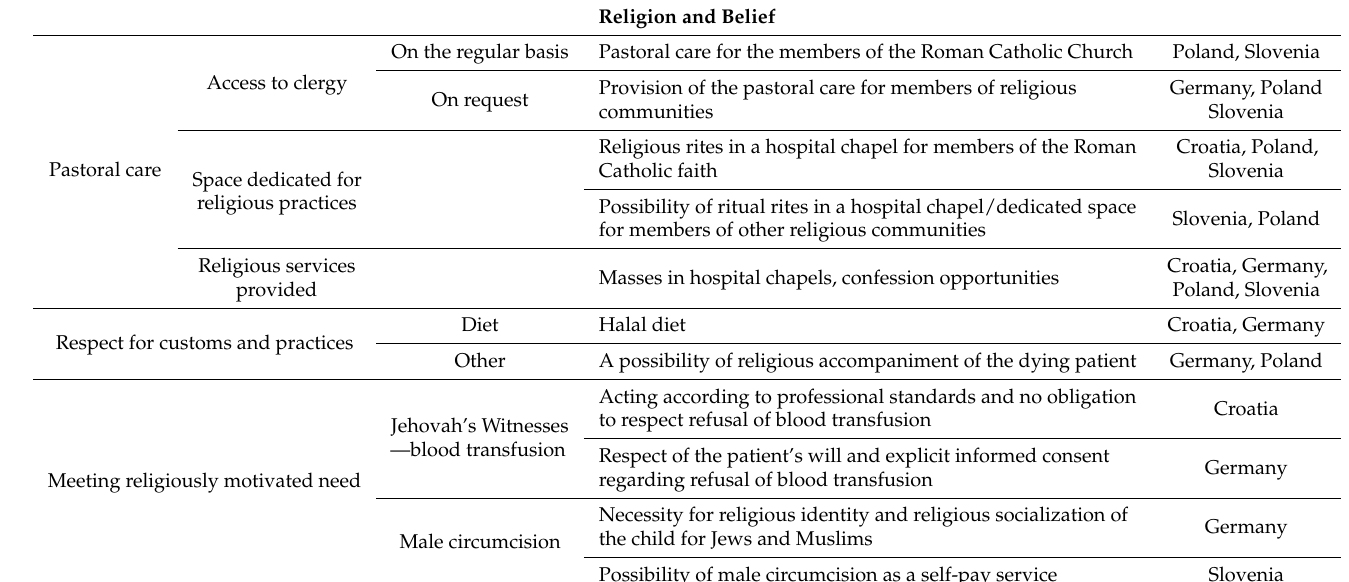
Table 4. Statements regarding religion in hospitals internal documents in Croatia, Germany, Poland, and